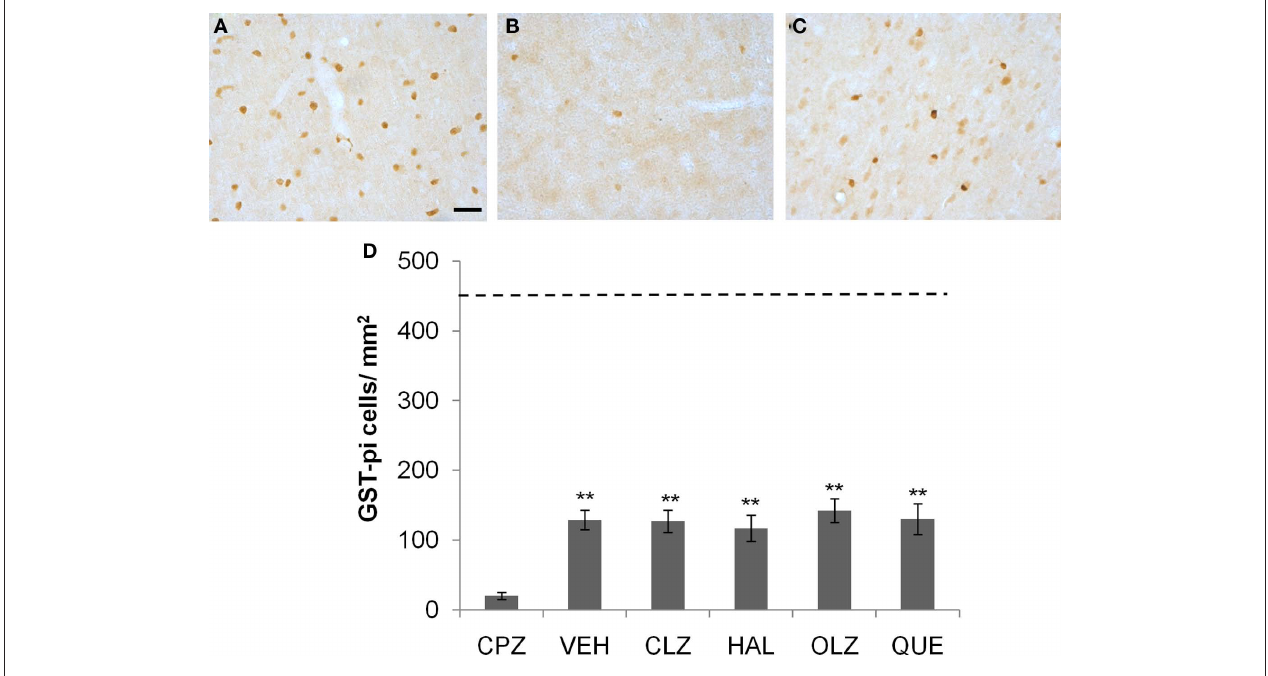
3-week recovery period after CPZ withdrawal. (D) The quantitative data (mean ± SEM; n = 5/group). The dotted line indicates the value of the CNT group, which was significantly higher than all other groups. ** p < 0.01, compared to the CPZ group. The scale bar in image (C) represents about 25